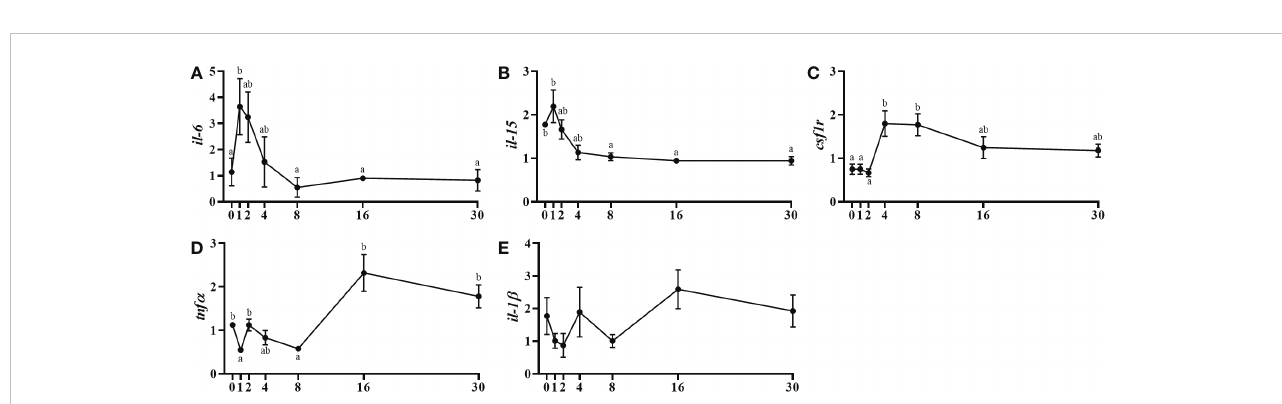
FIGURE 5 Relative gene expression of the in fl ammatory markers, il-6 (A) , il-15 (B) , csf1r (C) , tnf a (D) , il-1 b (E) in injured epaxial muscle of fi sh. Data are shown as means ± SEM, n=10. Statistical analysis was assessed by one-way ANOVA. Different letters indicate signi fi cant differences of factor time (days post-injury) (Tukey ’ s HSD or Games-Howell post-hoc test, p <